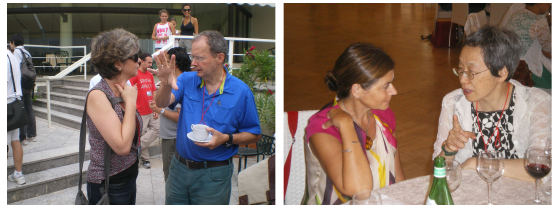
Figure 2: Meeting colleagues and having discussions represented, apart from scientific sessions, a key point of the workshop.